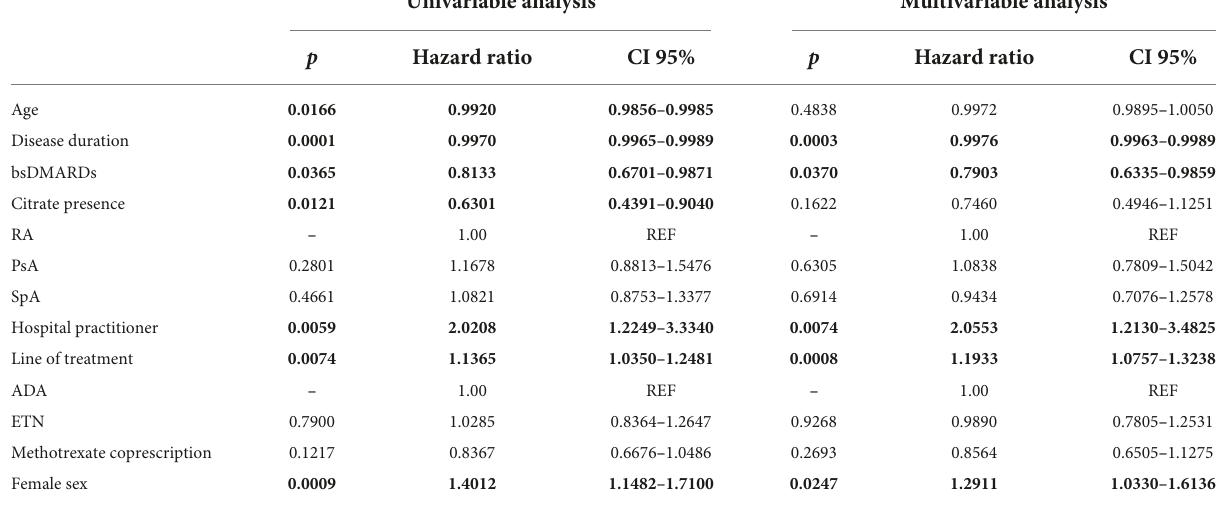
TABLE 2 Predictive factors of cessation of treatment in univariable and multivariable analyses. Univariable analysis Multivariable